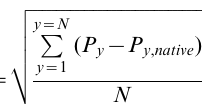
Figure 4. The results of structures clustering by Affinity propagation (AP) method for PHD2 species. The most fold cluster resides in left side of panels and the most unfold clusters reside in right side of panels. The structures’ clusters of a-PHD2, f-PHD2 and fh-PHD2 are depicted in panel A, B and C respectively. The panels are the results of affinity propagation clustering method. After reducing the dimensionality of the properties space used to build the d metric by n-MDS, AP clustering is performed. X and Y axes are the output vectors of n-MDS. Points represent structures in AP method. Clusters (states) are declared with different colors.